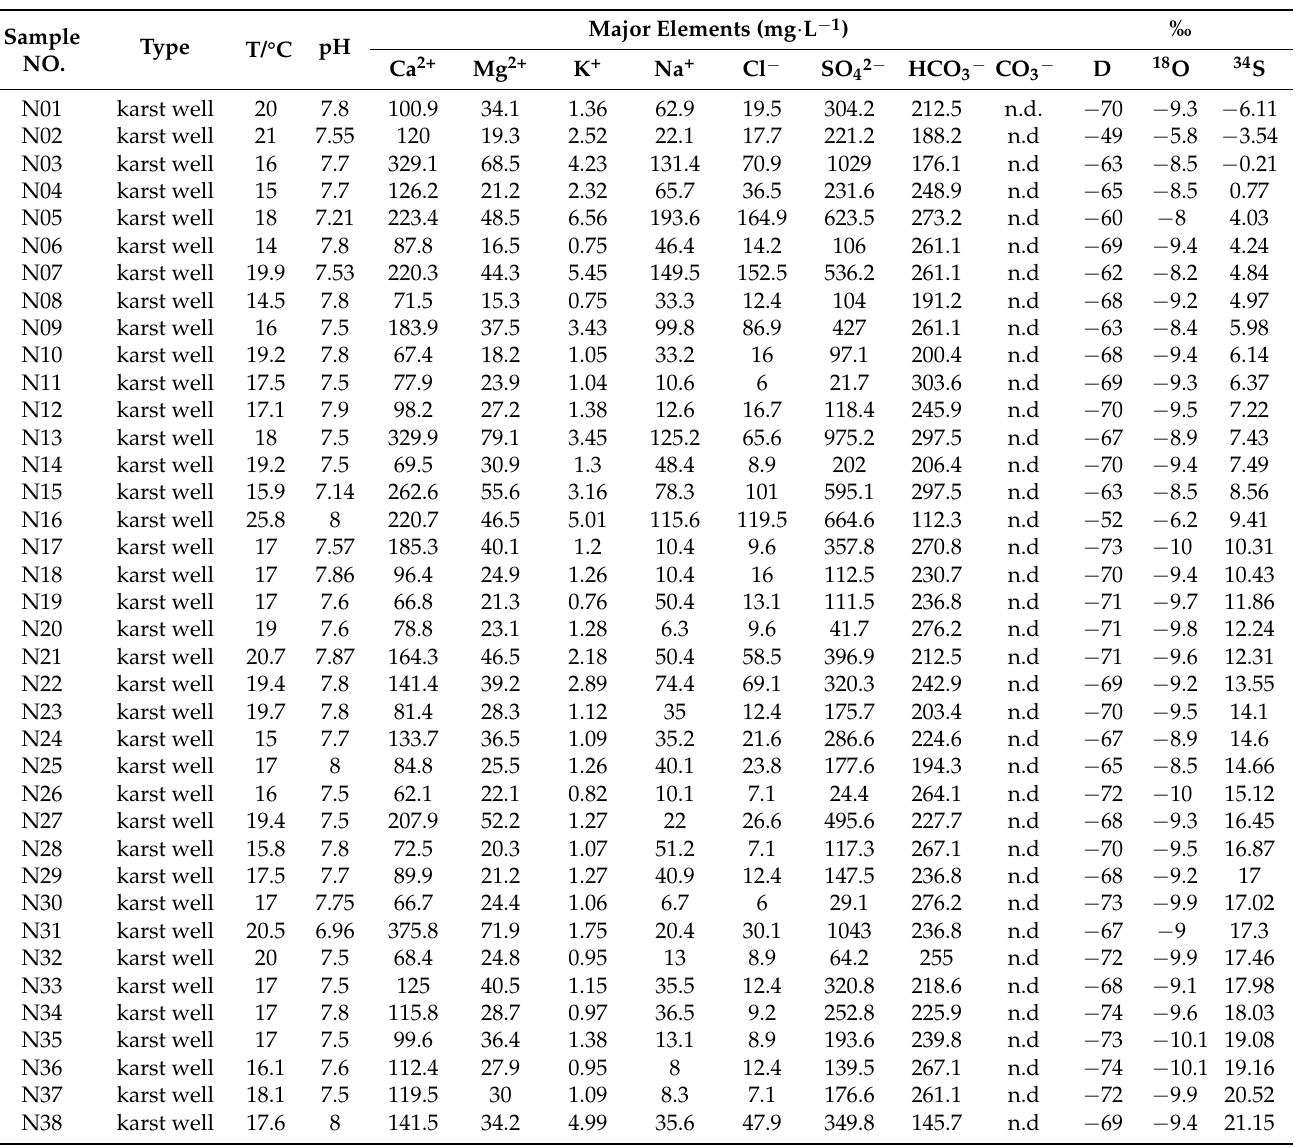
Table 1. Statistical summary of water quality parameters and stable isotopes in karst groundwater.